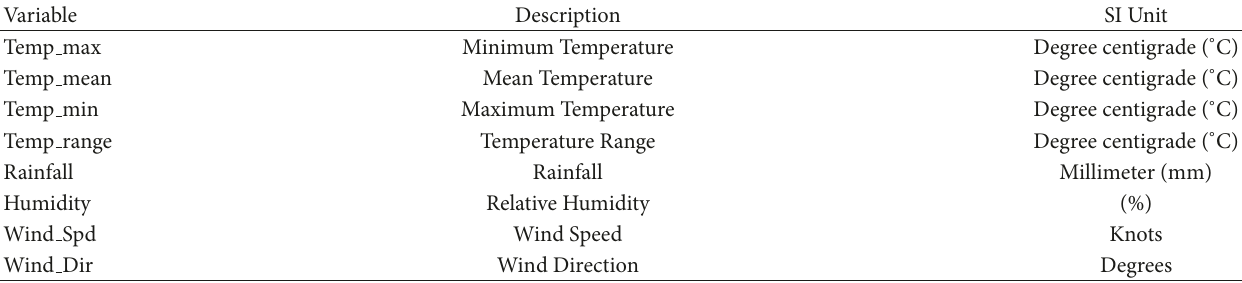
Table 1: Description of data for daily seasonal weather changes.